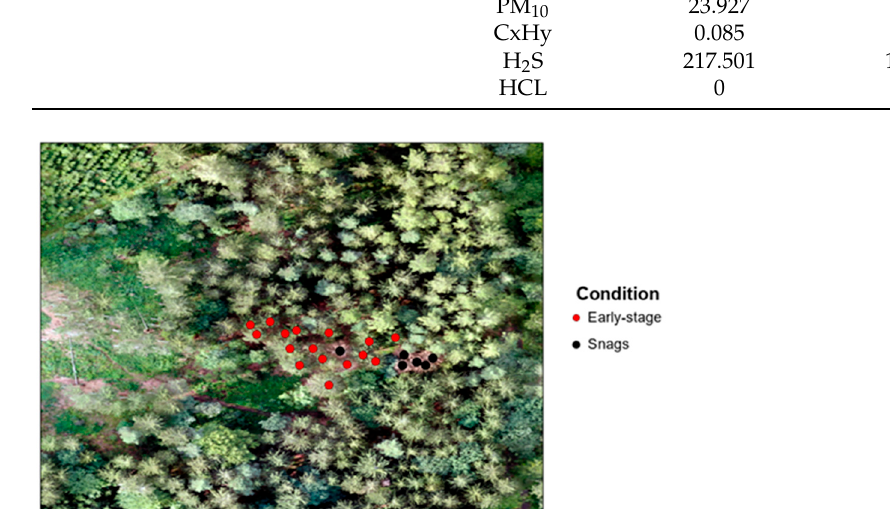
Figure 3. The orthomosaic was created from images taken from the UAV DJI Mavic with a visible spectrum in channel R, G, B. The image shows a point layer of trees; black points represent snags, red points indicate an early-stage infestation of trees, on the left is a clearing area; the other trees were not